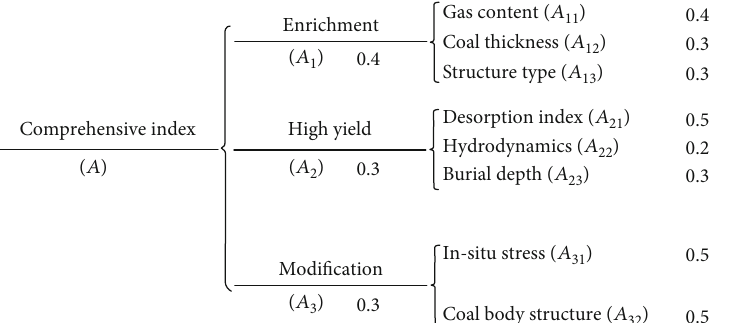
Figure 3: The AHP evaluation model with evaluation factors and their weights (numbers in the diagram show the weights in their current hierarchy).